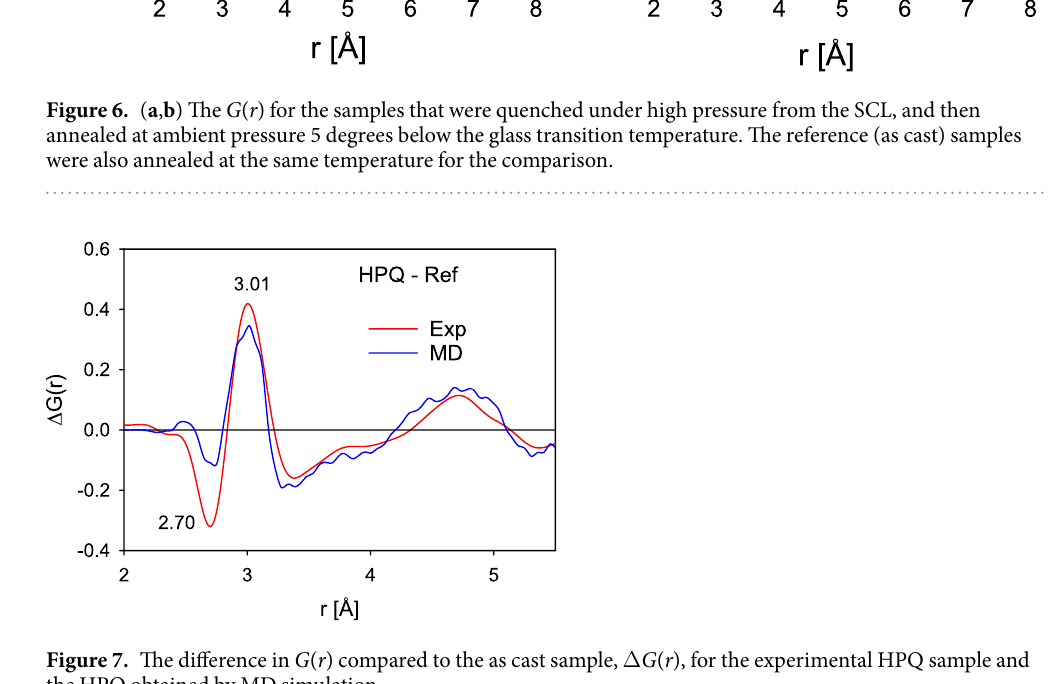
Figure S4a–c. The results show that the icosahedral clusters centered on Al and Cu are more frequently seen after applying pressure in the liquid state, however local polyhedral packing changes rather continuously with pressure (Figure S5a–c). The MD results are consistent with the idea that hydrostatic pressure in the SCL region leads to increased ordering and a new state with higher density (better packing). Nature of the structural change. The change in the structure with pressure (see Fig. 4) is not gradual but stepwise, occurring in the range below 4 GPa which is not accessible because of crystallization. For this reason we conclude that a phase change in the supercooled liquid state occurred , at a pressure between 0 and 4 GPa. However, we cannot determine the precise value of the critical pressure because at ~3 GPa and below SCL crystalizes. Also the isothermal compression of the SCL starting from ambient pressure is not viable because of the crystallization. Figure 1 shows the area where the high-pressure structure was observed by green shade. Note that this is not a phase diagram. The real phase boundary must be nearly vertical, and between 0 and 4 GPa, and the high-pressure phase should exist to the right of this line. However, it cannot be seen at high temperatures because of crystalliza- tion, limited by the black line in Fig. 1, and also at low temperatures because of glass transition (a nearly horizon- tal line near 720 K) because of kinetic slowdown. Consequently the high-pressure phase can be observed only in a very limited range of temperature and pressure, indicated by green shade.